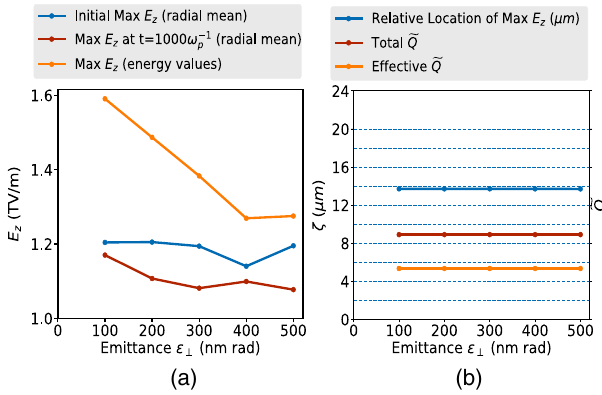
FIG. 4. (a) The variation of initial, final and average maximum axial longitudinal electric fields with charge. The beam is completely bunched and emittance is scaled linearly with charge ( 3 . 2 pC → 50 nm rad). (b) The location of the peak longitudinal electric field, total and effective normalized charge density also shown. The dashed lines correspond to the position of the bunches.